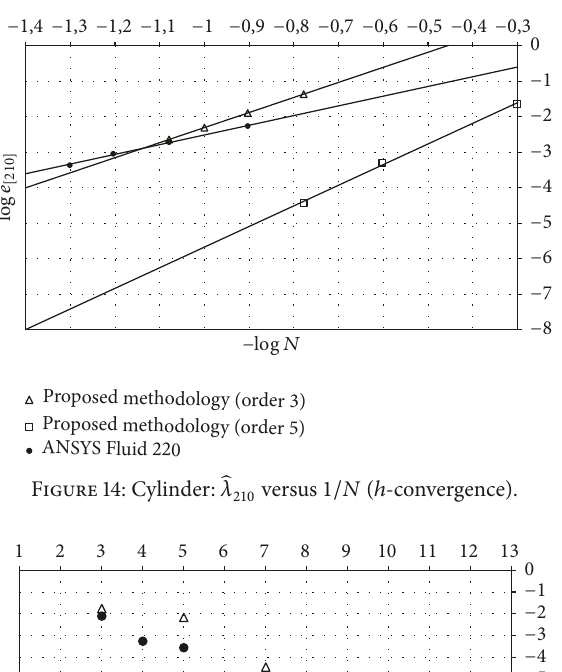
̂𝜆 1/𝑁 ( ℎ -convergence). 110 versus